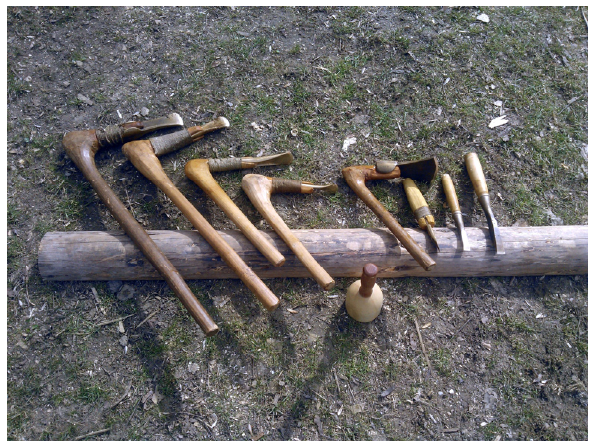
Figure 1. The selected eight different Bronze Age hand tool replicas; from left to right: two axes, three adzes and three chisels